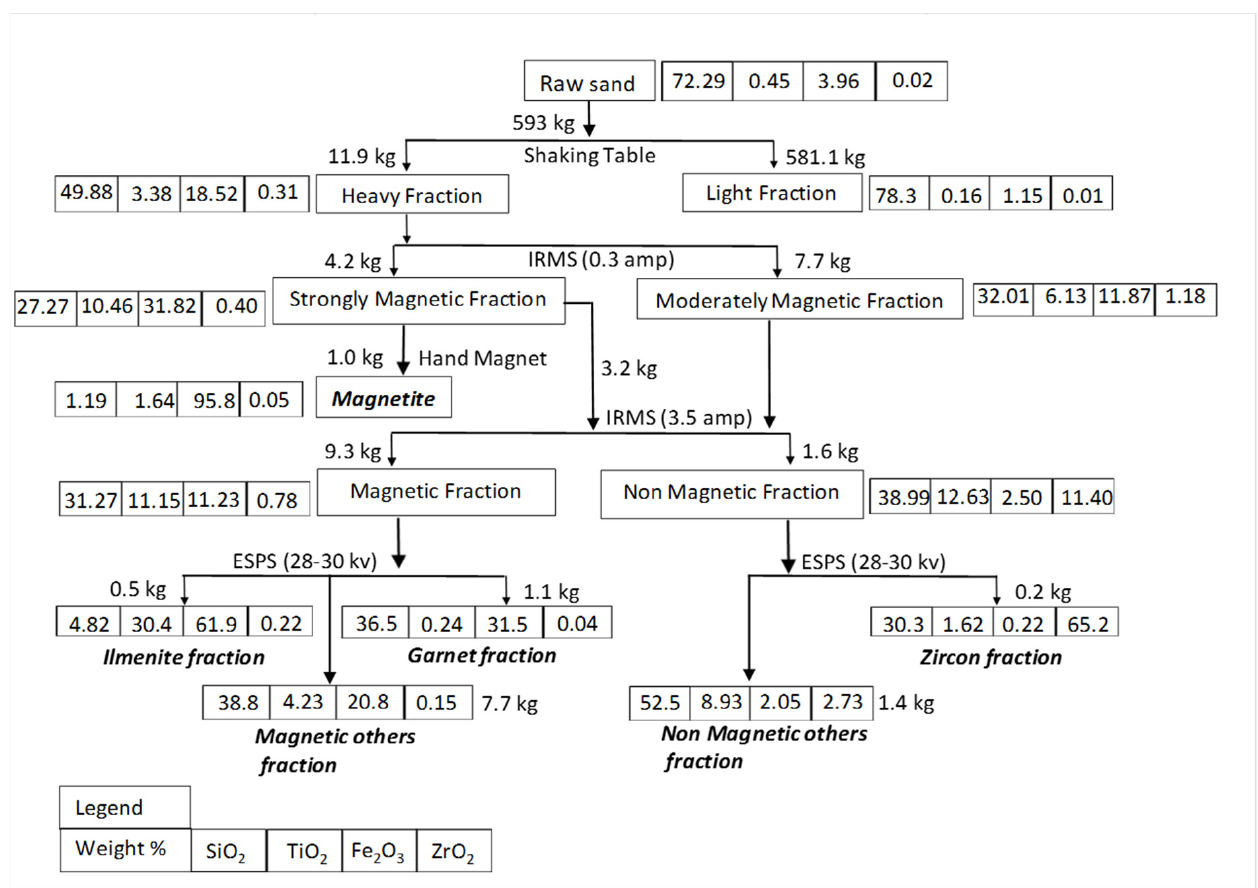
Figure 5. Process flow sheet with material balance showing the recovery of VHM from the combined Brahmaputra River sand, Kurigram District, Bangladesh.